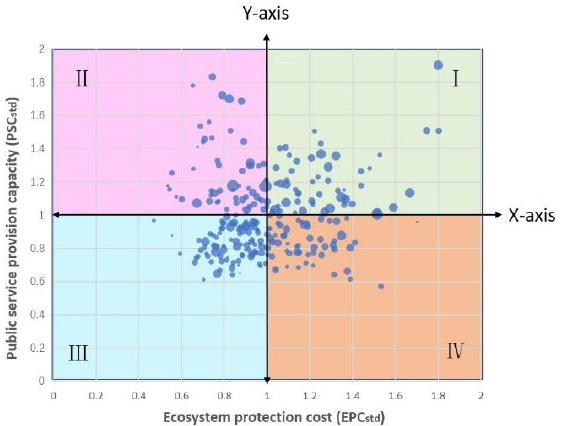
Figure 4. Quadrant chart for National Key Ecological Function County categorization. The dots in Figure 4 represent 255 counties, and according to different characteristics, the 255 points are divided into four quadrants and represented by Roman numerals (Table